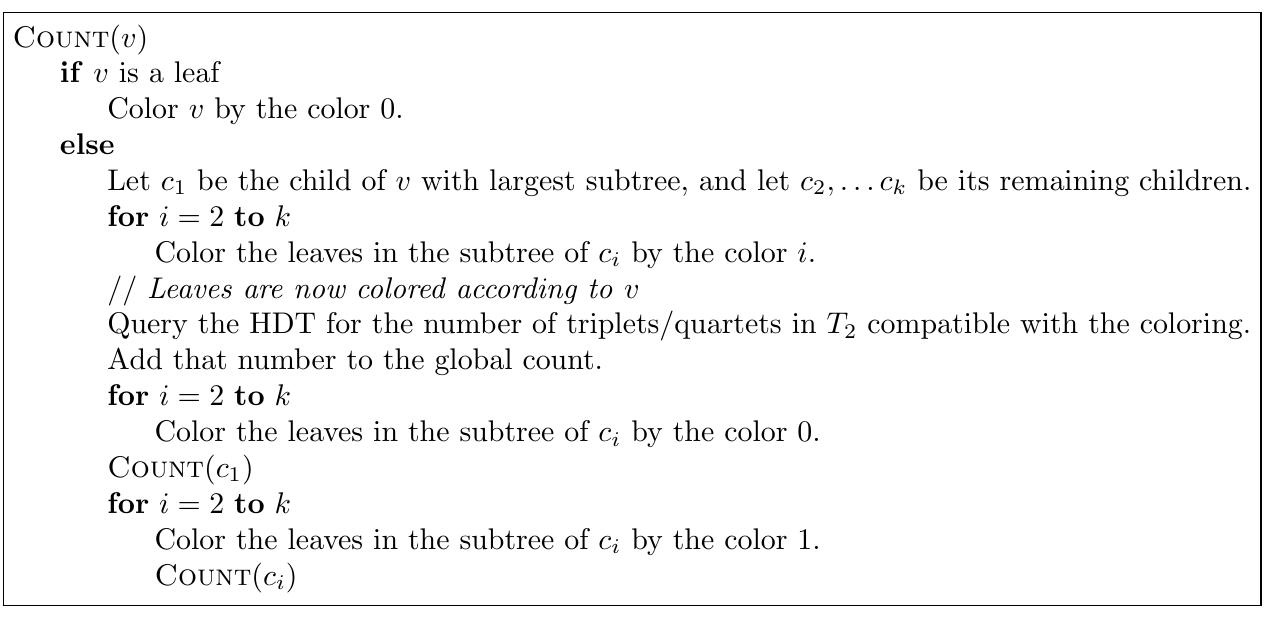
Figure 13. The main algorithm performing a recursive traversal of T